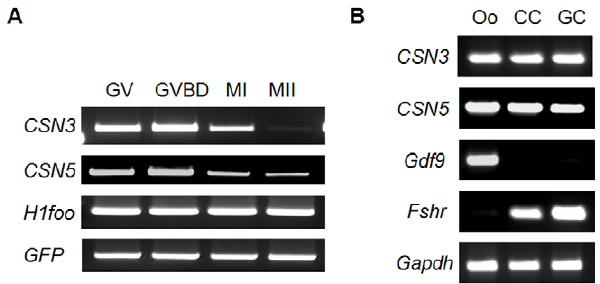
Figure 1. Expression of CSN3 and CSN5 mRNA in oocytes and follicular cells. (A) Expression of CSN3 and CSN5 mRNA in oocytes during in vitro maturation. For semi-quantitative PCR, single oocyte- equivalent cDNA was used as a template for amplification. GV, GVBD, MI, and MII oocytes were harvested at 0, 2, 8, and 16 h, respectively. Constitutively expressed oocyte-specific H1foo was used as an internal control and synthetic GFP mRNA was added to the lysates before mRNA isolation to compare the efficiency of mRNA recovery. (B) Expression of CSN3 and CSN5 mRNA in follicular components. Oo, oocytes at GV stage; CC, cumulus cells; GC, granulosa cells. Gdf9 and Fshr were used as markers for oocytes and granulosa cells, respectively.